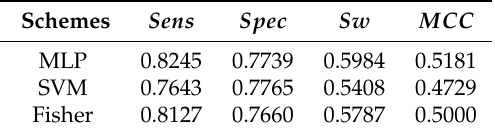
Table 7. Performance comparison with SVM and Fisher discriminant.